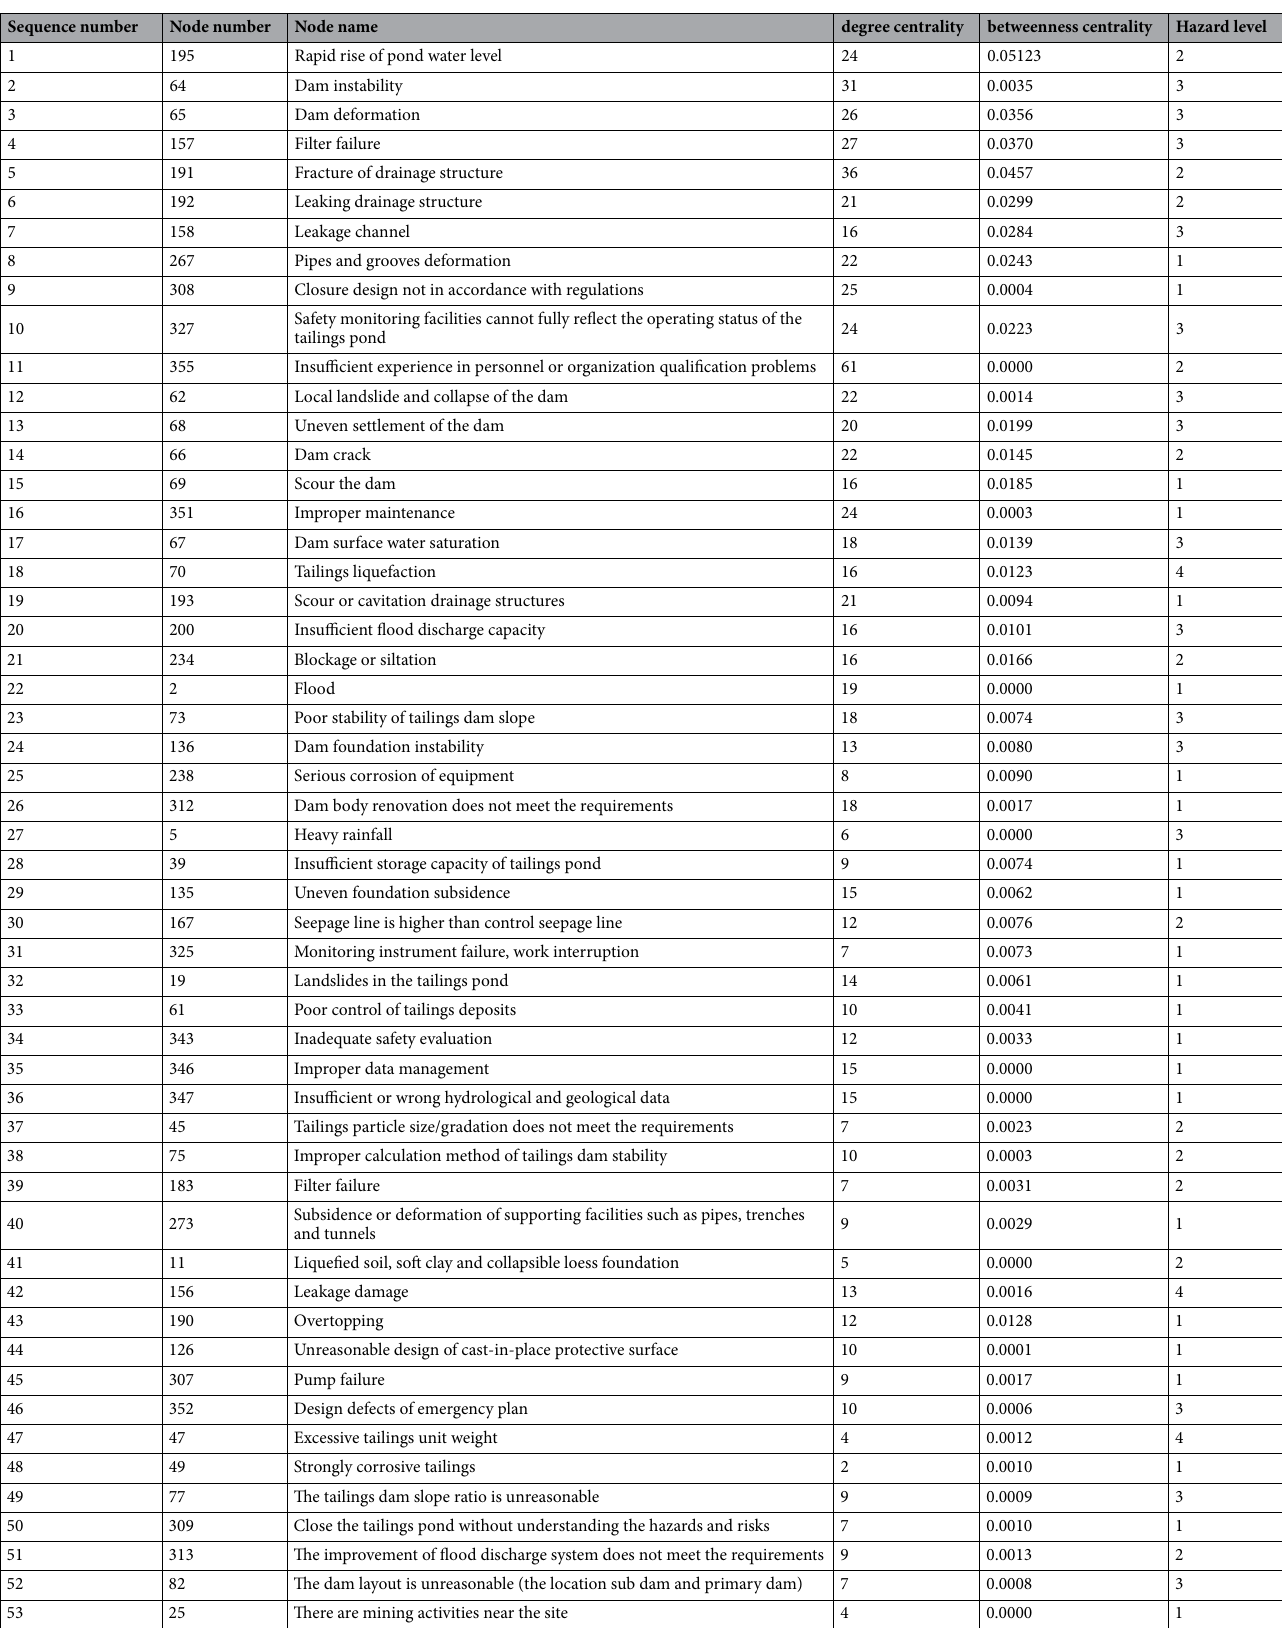
Table 1. Key hazards of Dam I